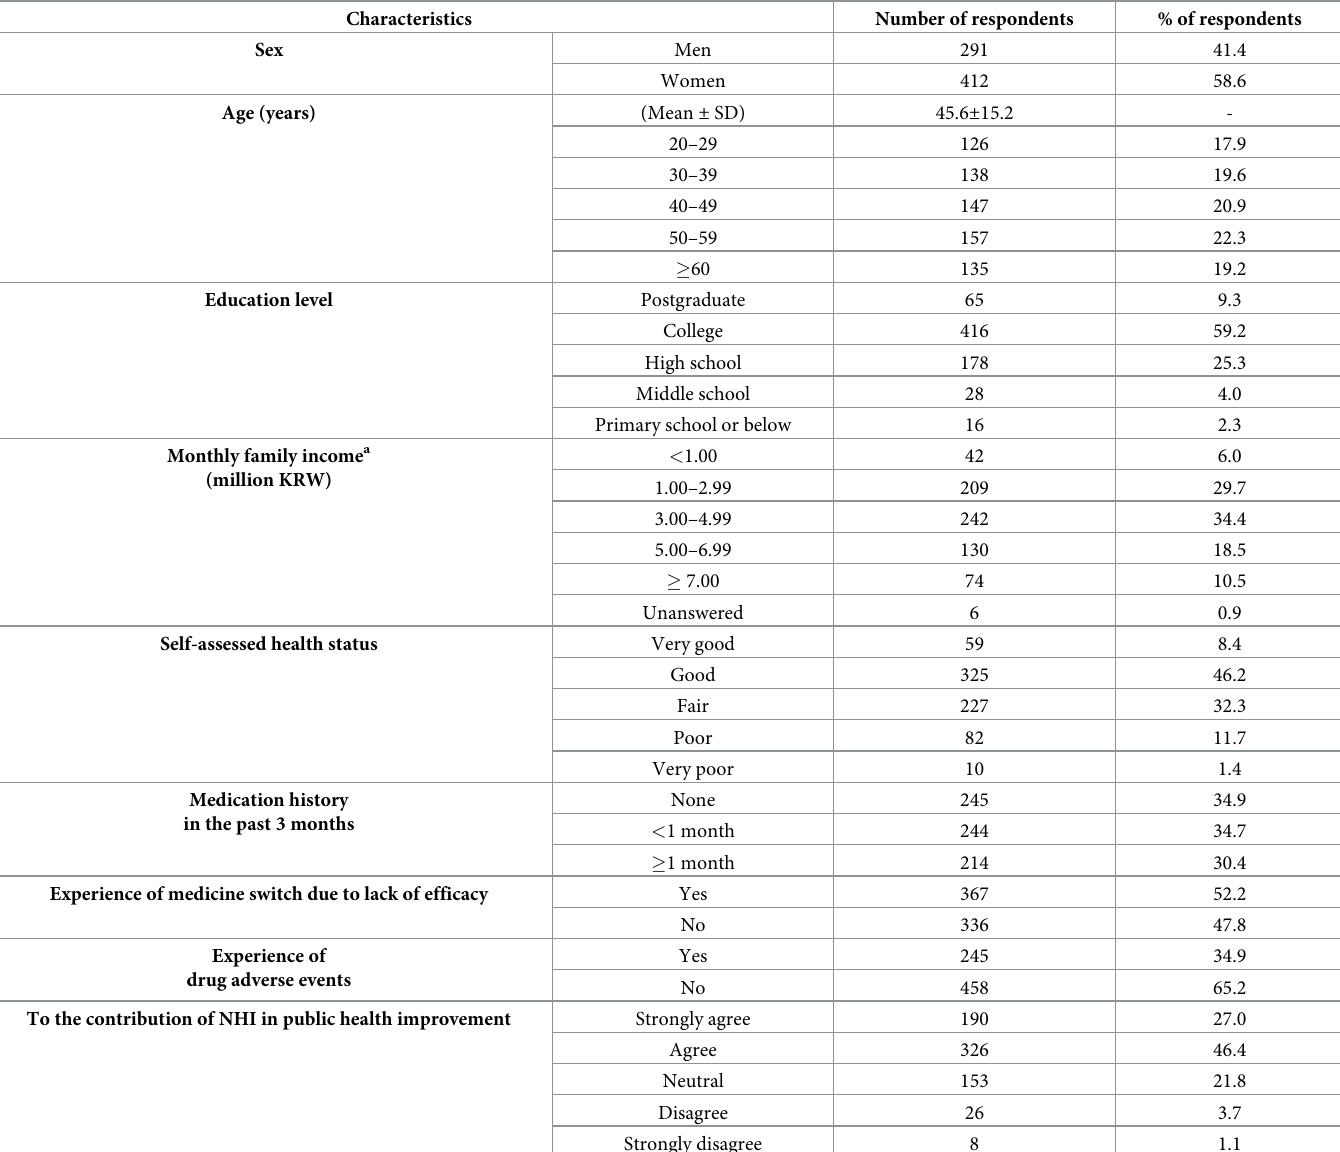
Table 1. Socio-demographic and health characteristics of the survey